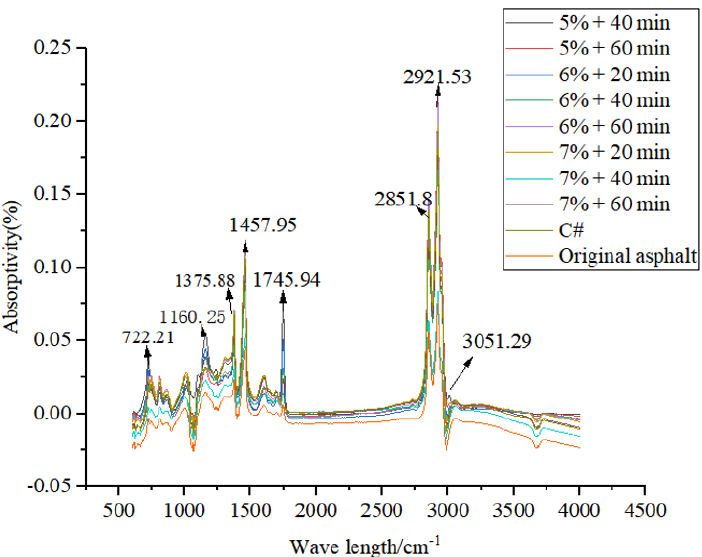
Figure 2. The infrared spectrum of each aging asphalt. In the vicinity of 3050 cm −1 , the aging asphalt with the regeneration agent produced new, wide and short peaks, as shown in Figure 3.